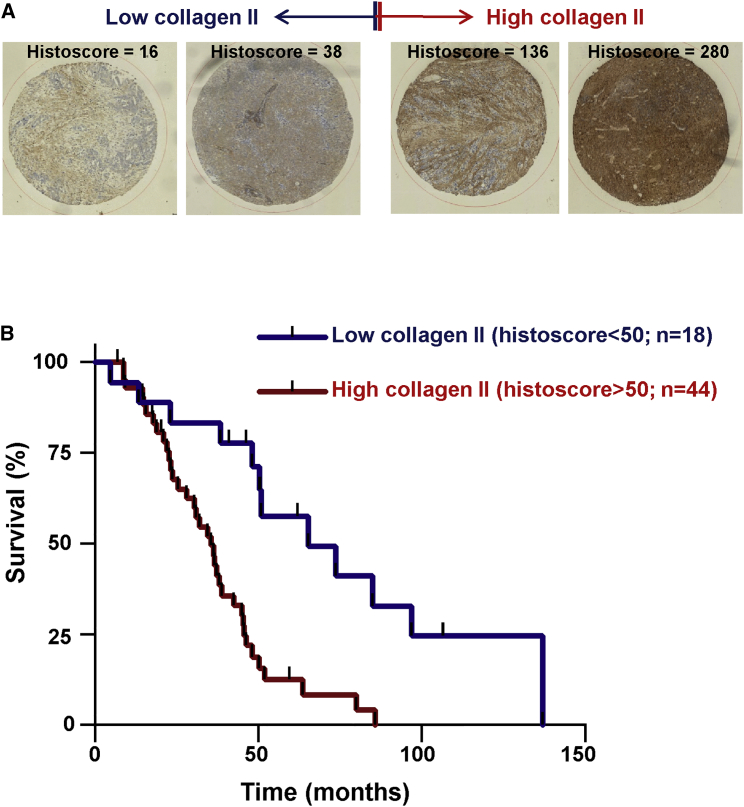
Type II Collagen Expression Predicts Poor Prognosis in Ovarian CancerA tissue microarray (TMA) containing 62 cases of ovarian cancer was stained for type II collagen. Examples of tumor cores displaying low (left side) and high (right side) histoscores for collagen II are displayed in (A). (B) shows a Kaplan-Meier analysis of patient survival when the cohort is divided into tumors with low (histoscore < 50) and high (histoscore > 50) collagen II expression. Patients with tumors displaying a collagen II histoscore greater than 50 have a 2.992-fold increased hazard ratio for death; p = 0.0002 (log rank test); n = 62. See Figure S7 for Kaplan-Meier analysis of the relationship between collagen II levels in the high-grade serous subset of these tumors.